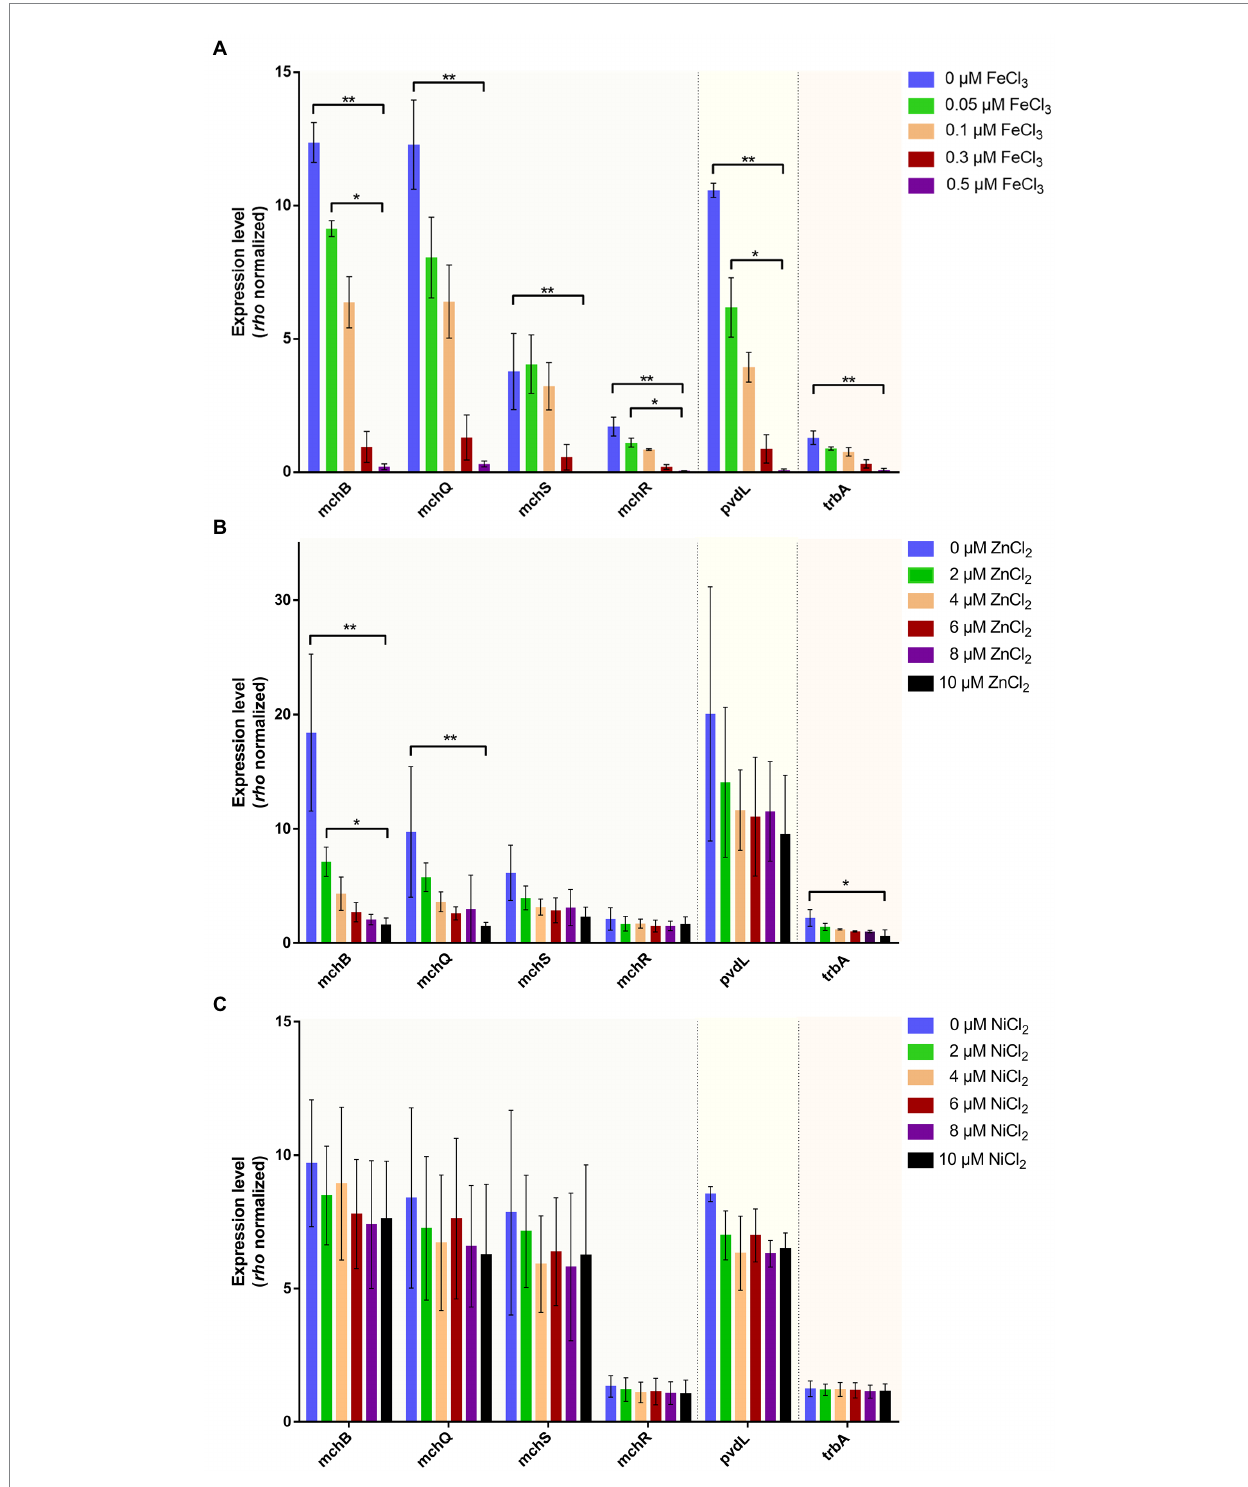
FIGURE 9 Effect of few metal concentrations on transcription for genes involved in pyoverdine ( pvdL ), mupirochelin ( mchB, mchQ, mchS, mchR ) and triabactin ( trbA ) pathways. (A) Increase in iron concentration in the culture medium is responsible for the repression of all the genes studied. At 0.5 μ M FeCl 3 the transcription of all genes is almost totally inhibited, even for mchR coding for the MchR transcriptional regulator of mch . (B) Increase in zinc concentration in the culture medium does not affect the transcription of pvdL indicating that pyoverdine may not have any specificity for Zn 2+ ions. On the contrary, it appears that the expressions of mchB and mchQ follow the same trend and decrease with zinc concentration. Concentration in Zn 2+ ion does not influence mchR gene transcription. trbA biosynthesis gene is also repressed by zinc concentration. (C) Increase in nickel concentration does not affect the expression level of all genes studied. All RT-qPCR analyses were conducted using rho as reference gene to study the level of expression of pvdL a biosynthetic gene of pyoverdine, mchB a biosynthetic gene of mupirochelin, mchR an AraC-like transcriptional regulator of mch cluster, mchQ and mchS coding TonB-dependent membrane receptors, and finally trbA , coding a siderophore synthase in the triabactin gene cluster ( n ≥ 3). For a given gene, comparisons between groups were performed by Kruskal–Wallis test followed by Dunn’s multiple comparisons test * p < 0.05, ** p < 0.01, *** p <